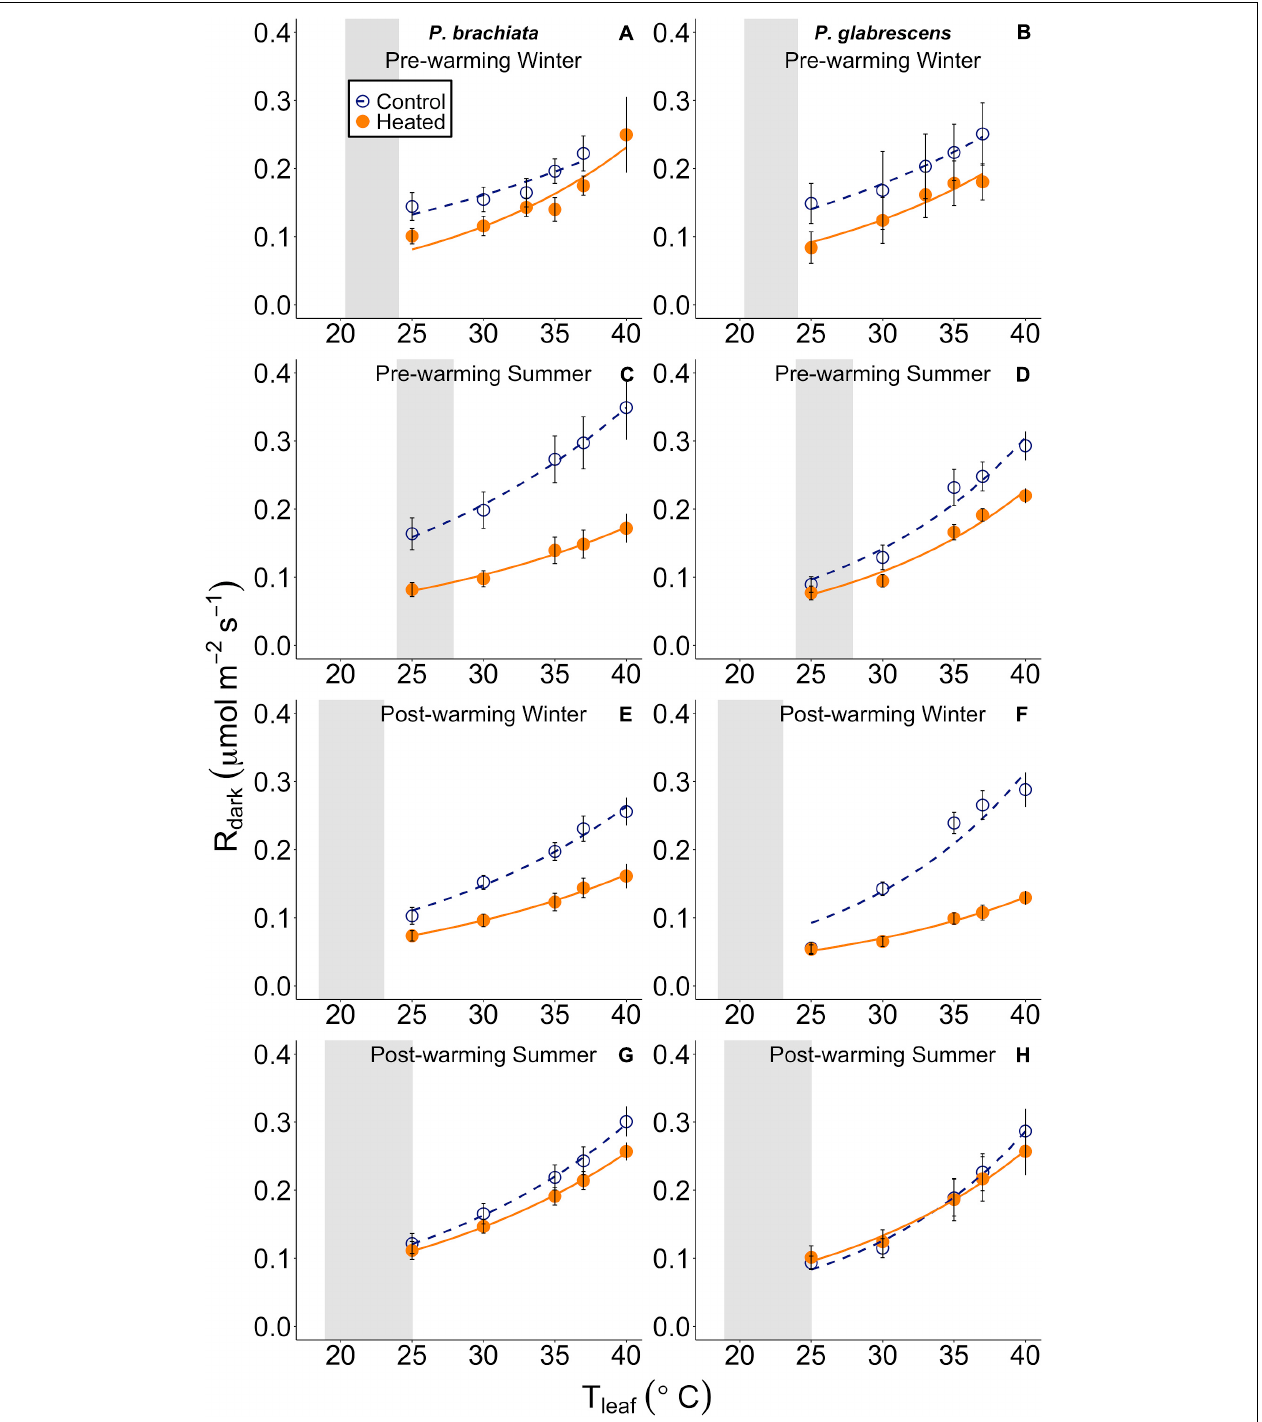
FIGURE 4 | Leaf respiratory ( R dark ) response to instantaneous leaf temperatures ( T leaf ). The respiratory response to temperature was plotted separately for each measurement campaign and species: (A) Psychotria brachiata pre-warming winter season, (B) Piper glabrescens pre-warming winter season, (C) P. brachiata pre-warming summer season, (D) P. glabrescens pre-warming summer season, (E) P. brachiata 4 months post-warming winter season, (F) P. glabrescens 4 months post-warming winter season, (G) P. brachiata 8 months post-warming summer season, (H) P. glabrescens 8 months post-warming summer season. Control plot (dark blue open circles) points and heated plot (orange; closed) points are means ± se at each leaf temperature. Exponential fit lines were fit to control (dark blue; dashed) and heated (orange; solid) plots separately. Gray boxes represent the range of the average minimum and maximum daily vegetation temperature for the control plots. Average minimum and maximum temperatures are calculated for each measurement campaign separately.